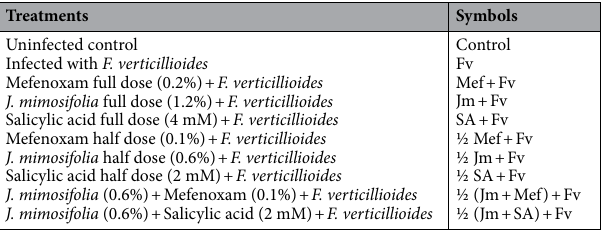
Table 1. The 10 maize seed treatments developed and tested in pot and field experiments.